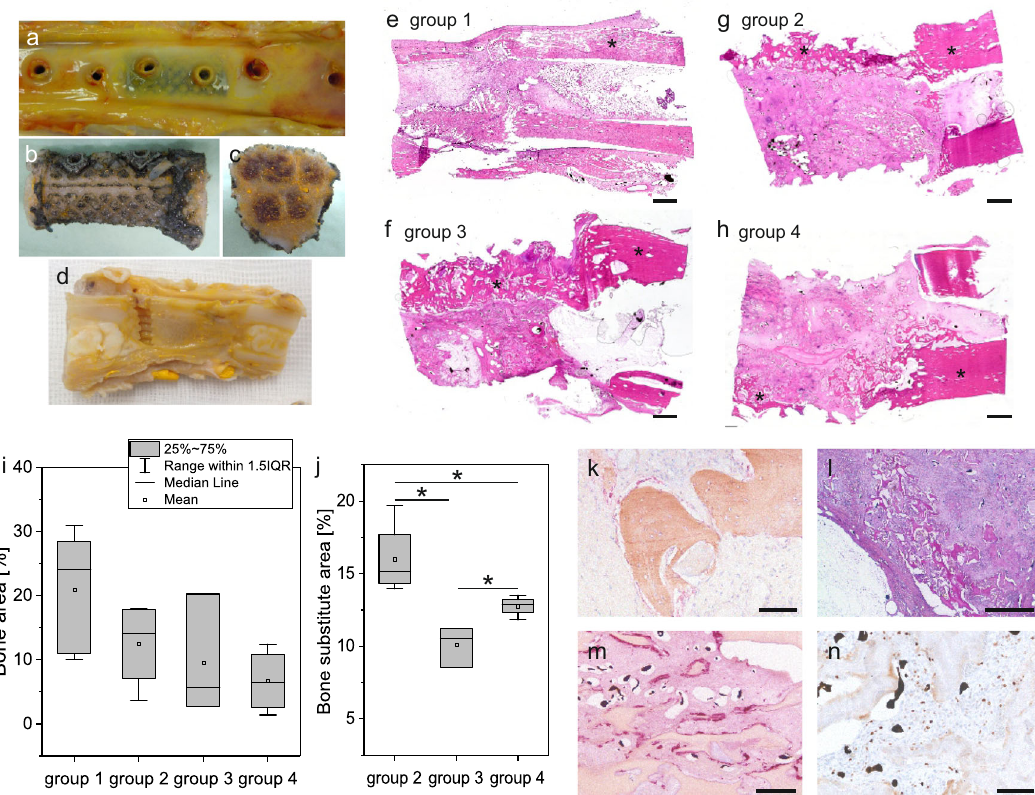
Fig. 3 Histological and immunohistological analysis of the newly formed bone area and degradation of the bone substitute. a – d Macroscopical images of the bone construct. a The chamber was completely integrated into the tibia and covered with connective tissue (representative picture of group 2). b Bone defect area after removal of the implantation chamber. c Cross section of the bone defect area (b/c representative picture of group 3). d Longitudinal section of the bone defect area (representative picture of group 1). e – h HE staining of histological slides of the bone defect area. Intact tibia on the right side of each slide (* = bone tissue). Scale bar 2 mm. i Quanti fi cation of the bone area and j quanti fi cation of bone substitute area in percentage (y-axis) of the whole region of interest among different experimental groups (x-axis). k Collagen type I (brown)/alkaline phosphatase (pink) double staining (representative picture of group 3). Scale bar 50 µm. l PAS staining (representative picture of group 3). Scale bar 1 mm. m TRAP staining (pink) for detection of osteoclast-like cells